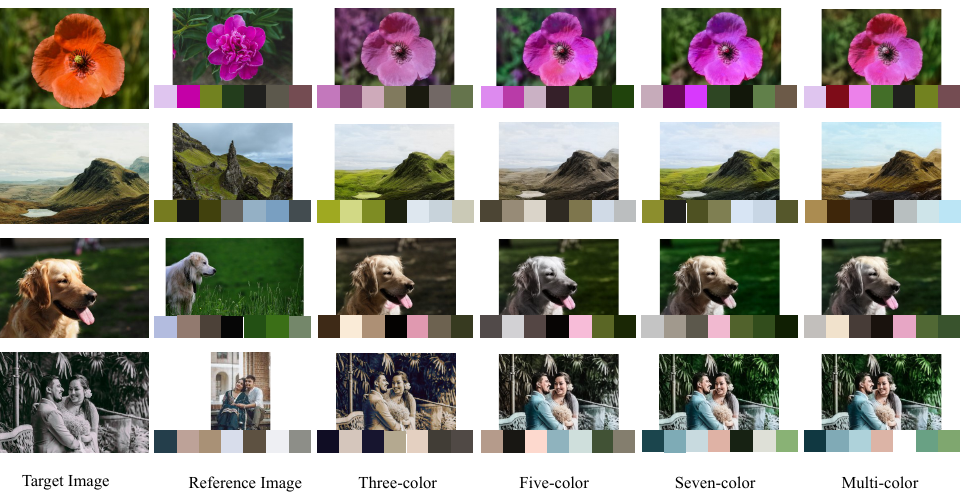
Figure 7. The effect of different color combinations on the coloring effect.